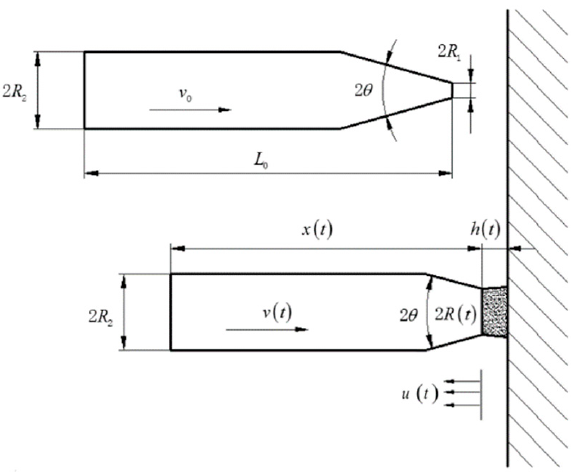
cross-section radius in the propagation of the elastic wave for a continuous variable circular cross-section. Using the truncated conical projectile as an example, the Taylor impact analysis diagram is shown in Figure 22, where the nose cone angle is 2 θ , the nose radius is R 1 , the radius of the cylindrical segment is R 2 , the initial projectile length is L 0 , and the initial impact velocity is v 0 .